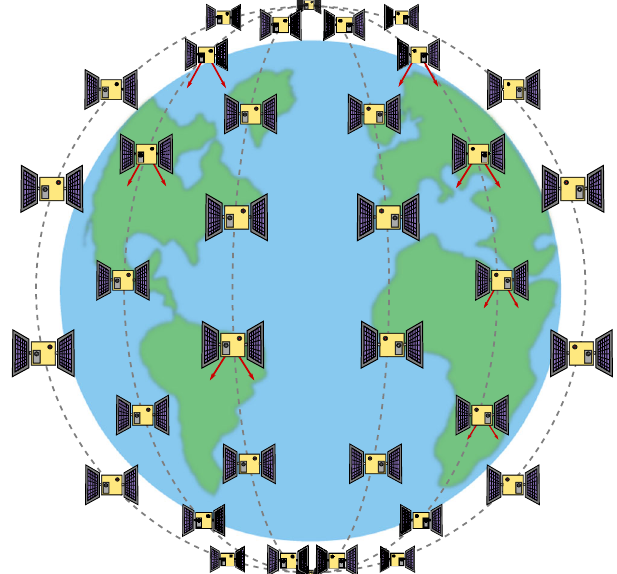
Fig. 2 Our proposed satellite-based quantum network. We allow for N R equally spaced rings of satellites. Within each ring, we allow for N S satellites in polar